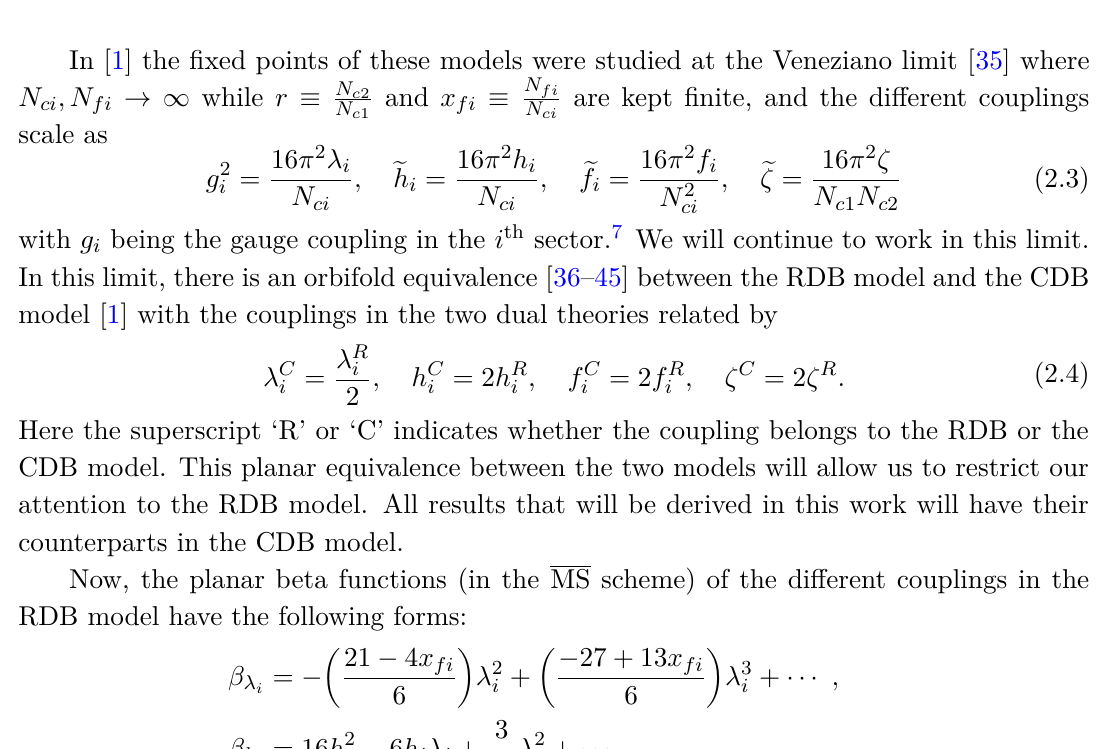
Figure 1. A schematic diagram indicating the representations in which the different fields trans- form in the double bifundamental models: the two sectors are represented by the two subdiagrams which are connected by a dashed line. This dashed line represents a double trace quartic interaction between the scalar fields in the two sectors. The two green nodes in each sector represent the two G i ’s in the gauge group G i × G i of that sector. Each of these G i ’s is SO( N ci ) for the RDB model and SU( N ) for the CDB model. The line connecting the two green nodes in each sector represents ci the scalar fields in that sector which transform in the bifundamental representation of G . i × G i These scalar fields interact via both single trace and double trace quartic couplings. The two yellow nodes in each sector represent the N flavors of the two fermions ψ and χ in that sector. Each line fi i i connecting a green node and a yellow node indicates that the respective fermion is an ( N ) ci × N fi matrix which transforms in the fundamental representation of the corresponding G i